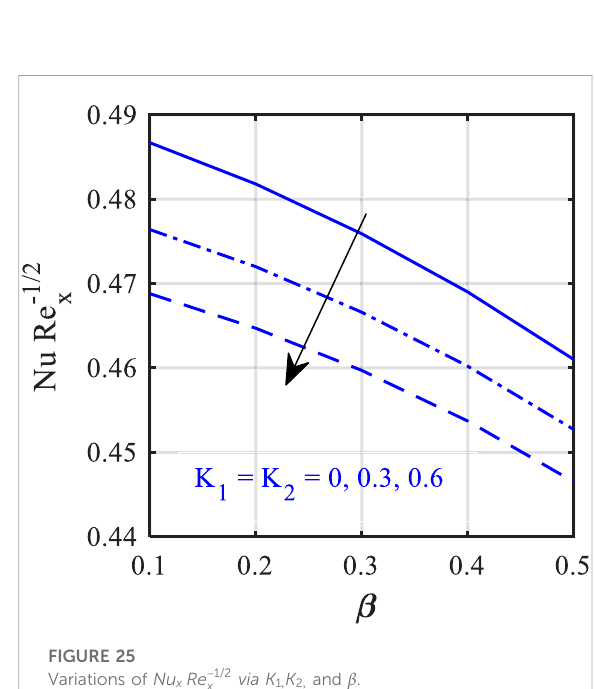
FIGURE 22 Variations of Cf x Re 1/2 x via M and λ .